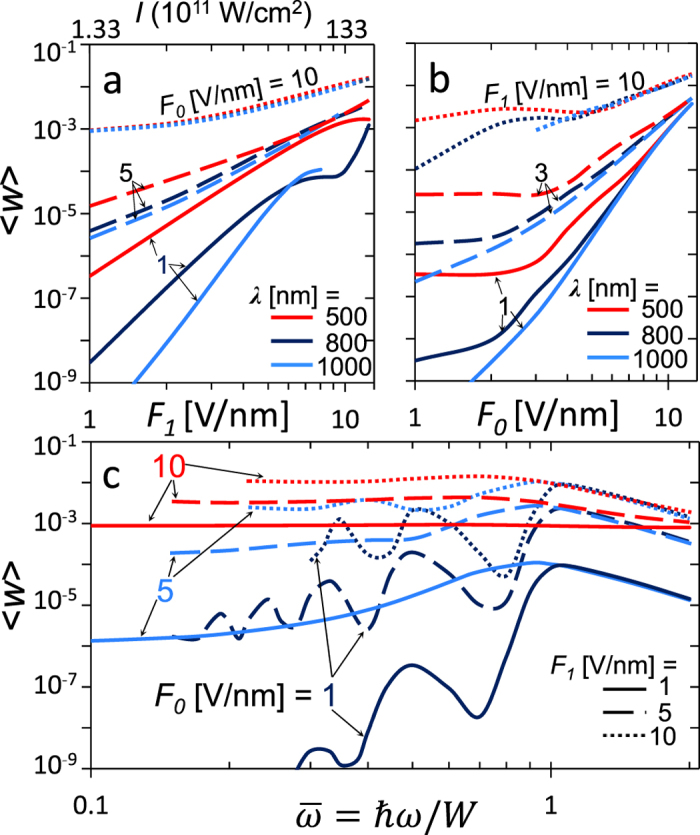
The effects of laser frequency (or wavelength) on the electron emission current density .(a)  as a function of F1 (and I), for various wavelength λ with different F0. (b)  as a function of F0, for various λ with different F1. (c)  as a function of laser frequency , for various combinations of F1 and F0. For the laser electric field F1 = 1, 5 and 10 V/nm, the corresponding laser intensity I [W/cm2] = 1.33 × 1011 × (F1[V/nm])2 is 1.33 × 1011, 3.33 × 1012 and 1.33 × 1013 W/cm2, respectively.